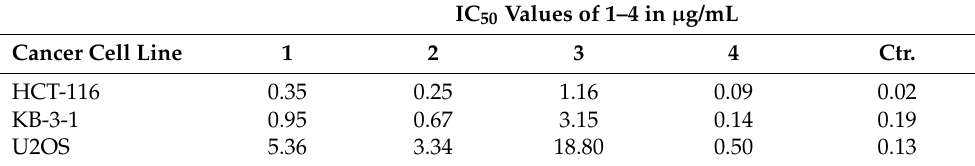
Table 2. Half maximal inhibitory concentrations (IC 50 values in µ g/mL) of stigmatellic acid ( 1 ), iso -methoxy stigmatellin ( 2 ), stigmatellin C ( 3 ), stigmatellin A ( 4 ) and doxorubicin as well-known cytotoxic drug as control (Ctr) against HCT-116 (human colon carcinoma cell line, DSMZ No. ACC 581), KB-3-1 (cervix carcinoma cell line, DSMZ No. ACC 158) and U2OS human bone osteosarcoma epithelial